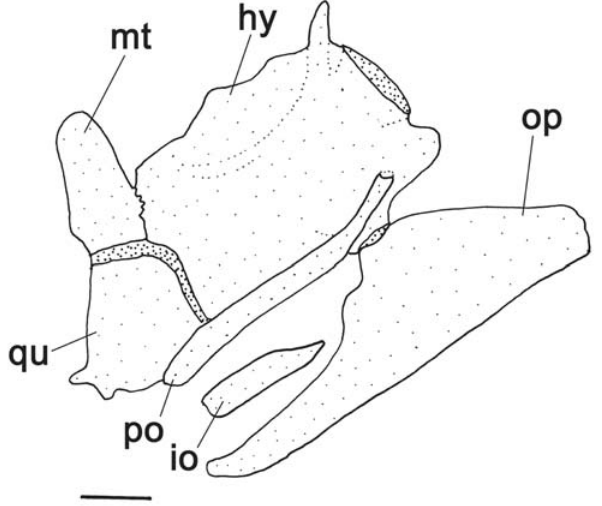
Fig. 6. Right hyoid arch of Microglanis pataxo , MNRJ 28398, paratype. Medial view. Abbreviations: ac, anterior ceratohyal; br, branchiostegal rays; ic, interceratohyal cartilage; pc, pos- terior ceratohyal; vh, ventral hypohyal. Scale bar, 1